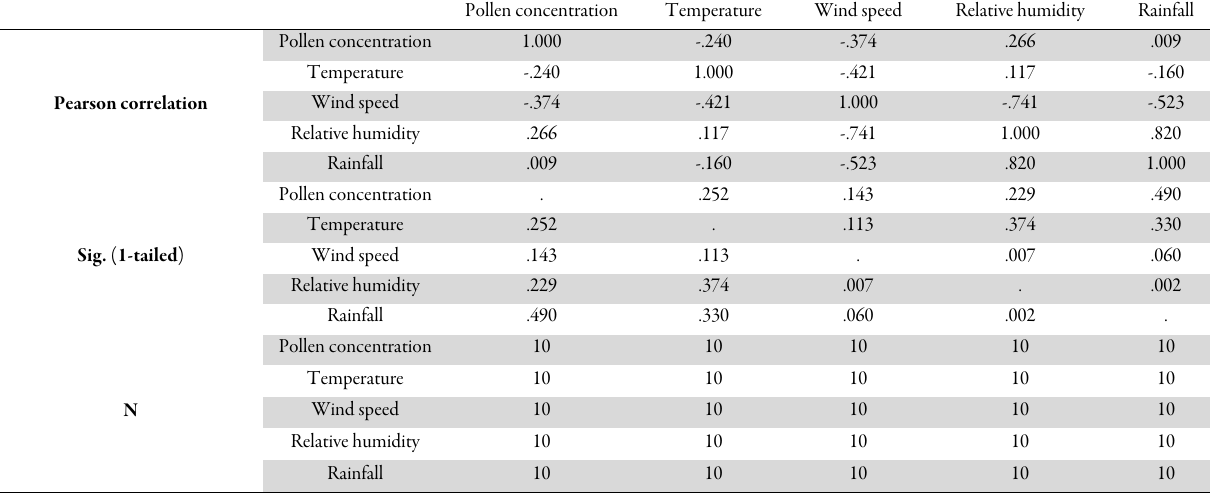
Table 5. Relationship between monthly pollen concentrations and values of mean meteorological parameters at the study site in Kaduna state at 95% confidence interval (P < 0.05)